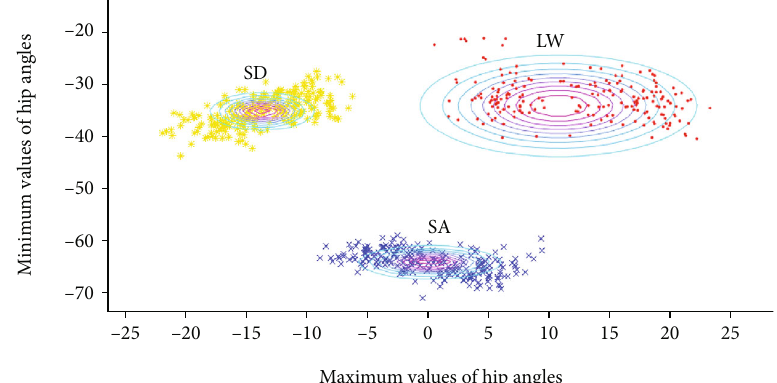
Figure 5: The distribution of the data of LW, SA, and SD (denoted by the dots) and the calculated membership function (represented by the ellipses). The data of LW, SA, and SD were represented as the yellow dots, the red dots, and the blue dots, respectively. The data were collected from subject